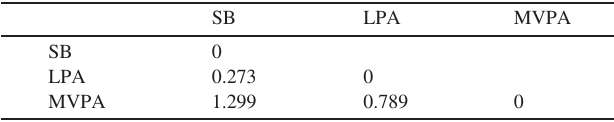
Table 2. Variation matrix of time spent in activity